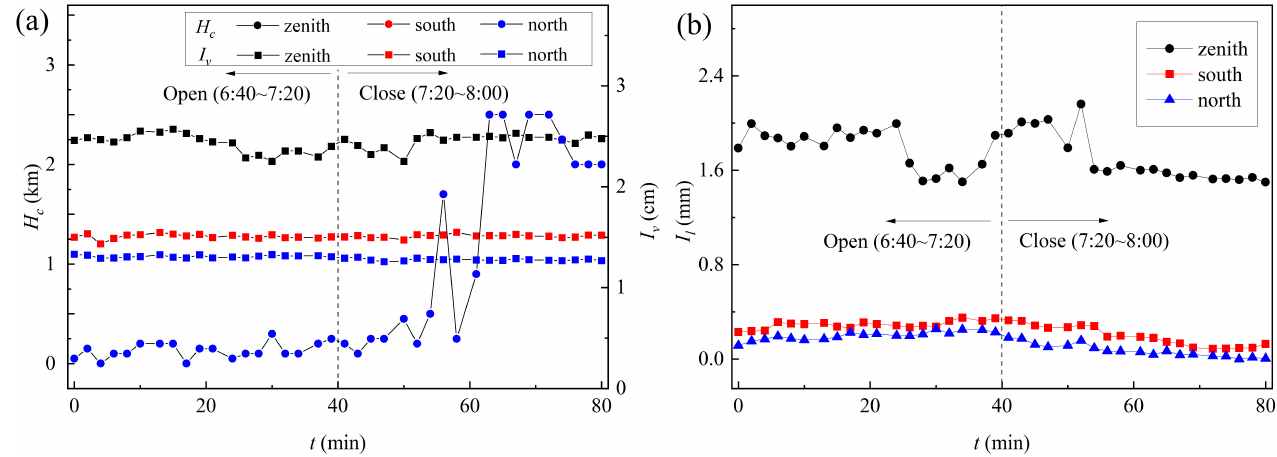
Figure 7. Temporal evolution of H c , I v ( a ), and I l ( b ) measured by MWR in the zenith direction of the field site.